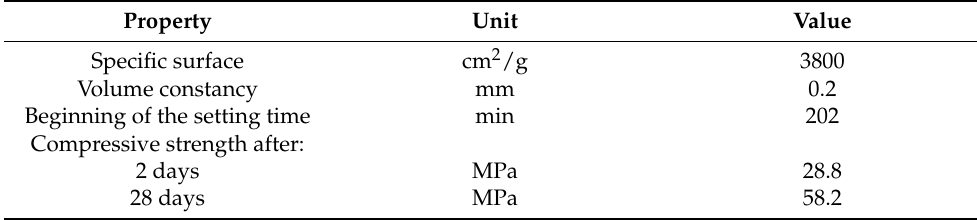
Table 1. Physical and mechanical properties of the used cement.